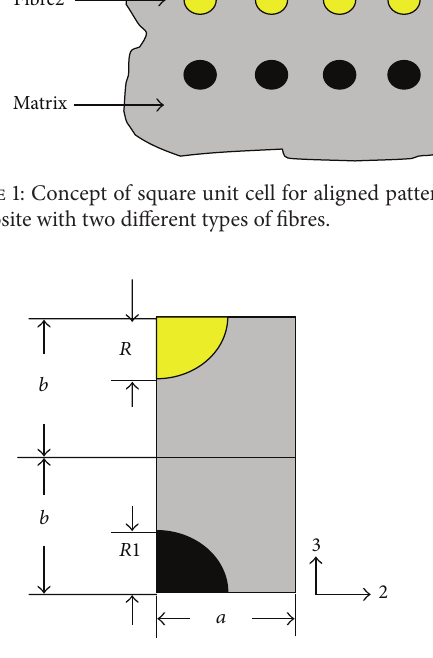
Figure 2: One-fourth model of unit cell for aligned pattern of